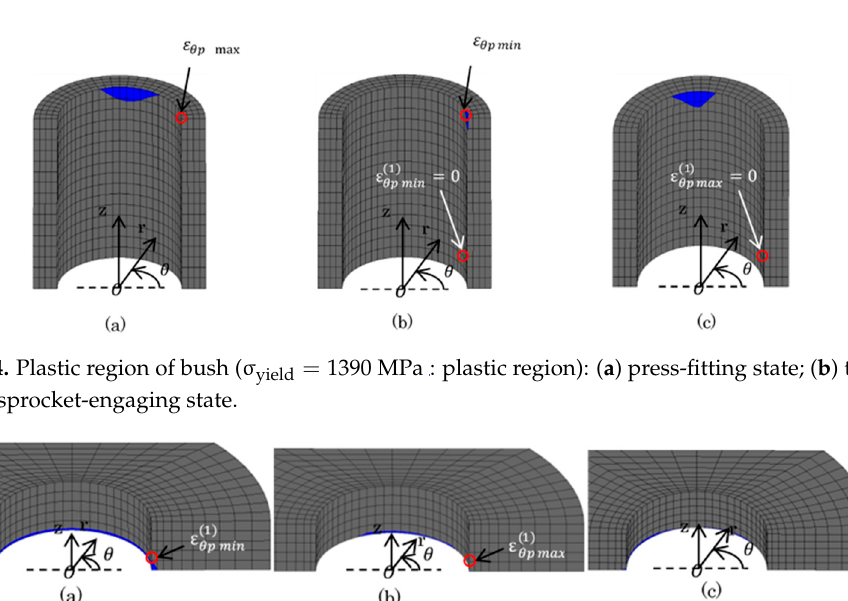
Figure 16. Plastic region of outer plate ( σ yield (cid:3404) 970 MPa : plastic region): ( a ) press-fitting state; ( b ) tensile state; ( c ) sprocket-engaging state. As described above, since the plastic region was observed, the following is a discussion of damage assessment from the viewpoint of low cycle fatigue. Damage evaluation in low cycle fatigue is evaluated based on Manson–Coffin's rule shown in the following equation: kp θp f